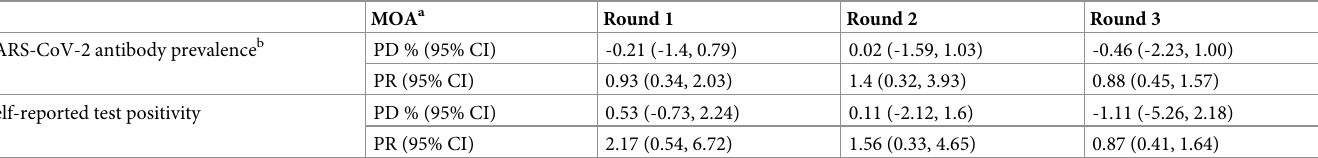
Table 5. Association of high-risk vs. low-risk mitigation behavior with seroprevalence and self-reported test positivity and within each study